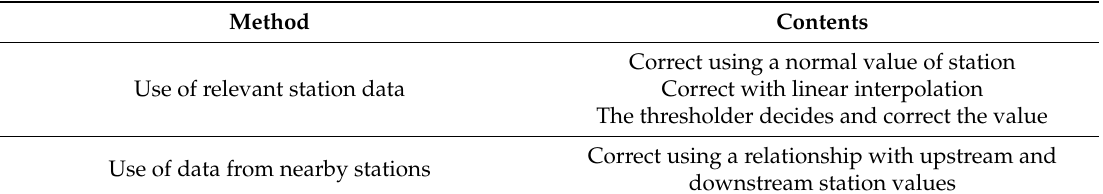
Table 2. Correction method for outlier and missing value of hydrological data